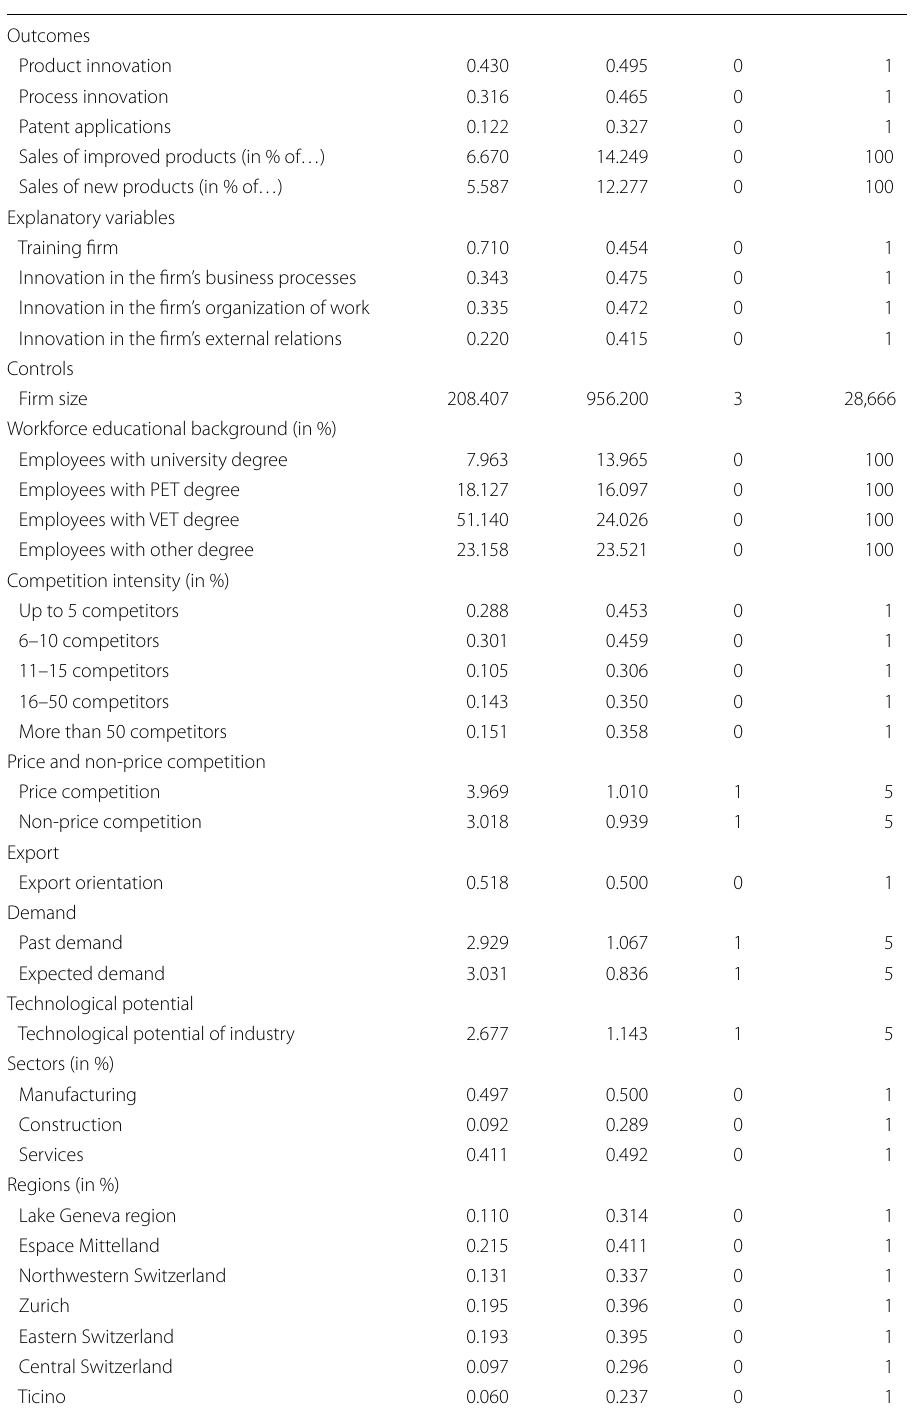
1,240) included in the analysis = Mean Std. dev Min